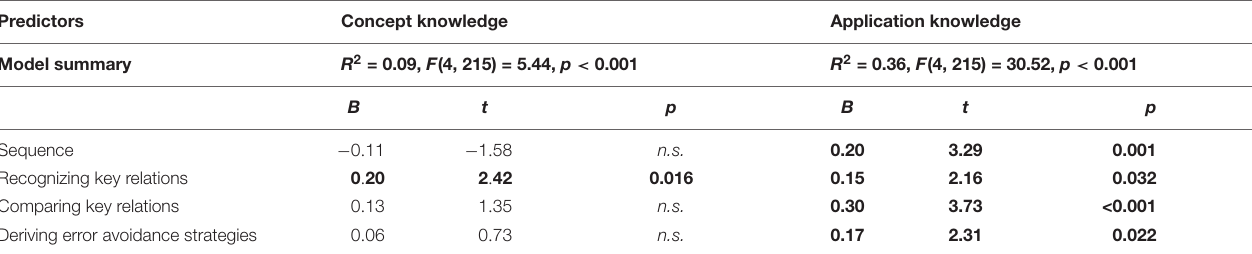
TABLE 6 | Results of regression models with concept knowledge and application knowledge as dependent